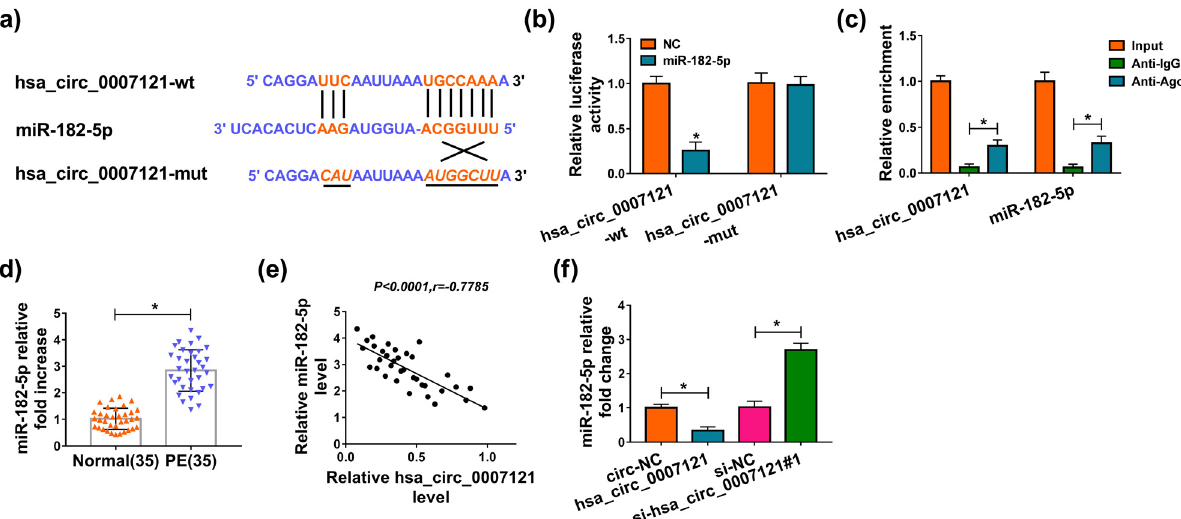
Figure 3: Hsa_circ_0007121 directly interacted with miR - 182 - 5p. ( a ) The potential target sites between miR - 182 - 5p and hsa_circ_0007121 were predicated by CircRNA interactome. ( b and c ) The dual - luciferase reporter assay and RIP assay were performed to investigate the interaction between miR - 182 - 5p and hsa_circ_0007121. ( d ) The level of miR - 182 - 5p in PE placental tissues ( n = 35 ) and normal placental tissues ( n = 35 ) was detected by qRT - PCR. ( e ) The correlation between miR - 182 - 5p and hsa_circ_0007121 in PE placental tissues was analyzed by Pearson ’ s correlation coe ffi cient. ( f ) The expression level of miR - 182 - 5p was measured by qRT - PCR in HTR - 8/SVneo cells transfected with circ - NC, hsa_circ_0007121, si - NC, or si - hsa_circ_0007121#1. * P <